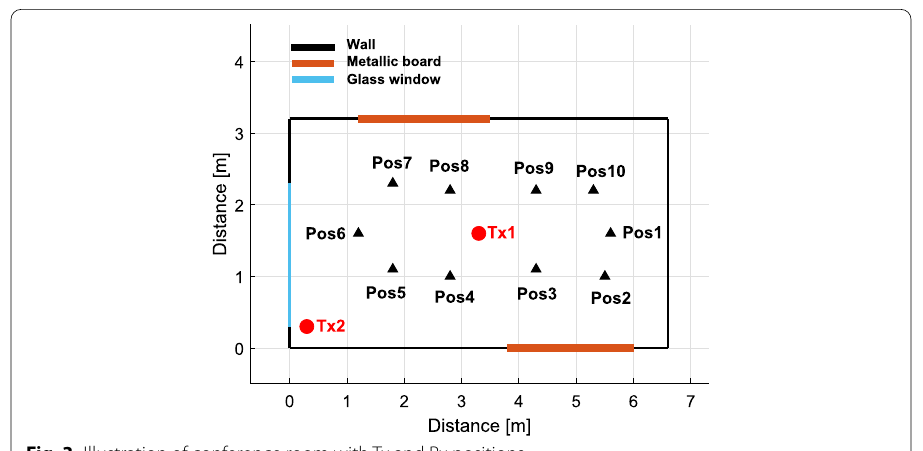
Fig. 3 Illustration of conference room with Tx and Rx